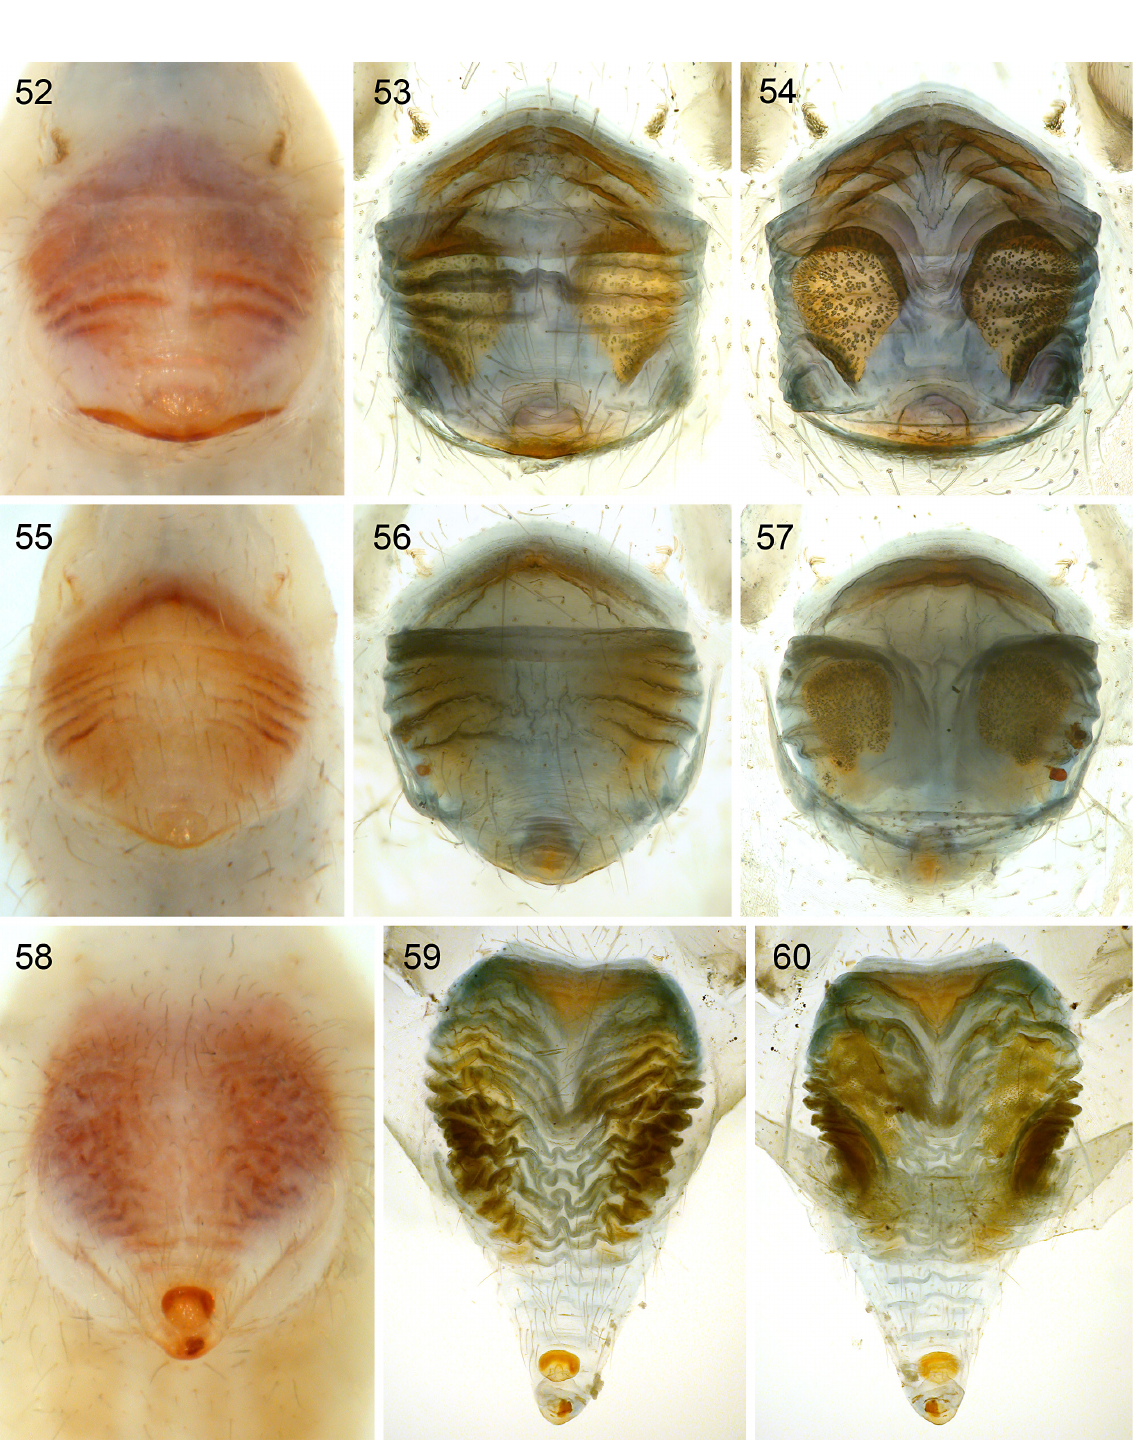
Figs 52–60. Female genitalia, untreated in ventral view, cleared in ventral and dorsal views. 52– 54 . Panjange pueh Huber, sp. nov. (ZFMK Ar 14577). 55–57 . Pa. niah Huber, sp. nov. (ZFMK Ar 14580). 58–60 . Pa. kapit Huber, sp. nov. (ZFMK Ar